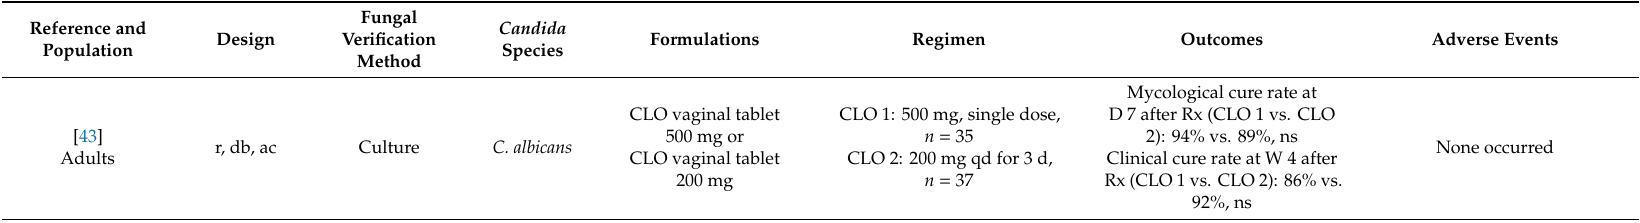
Table 2. Randomized controlled studies comparing di ff erent treatment regimens or formulations of intravaginal clotrimazole in women with uncomplicated (acute) vulvovaginal